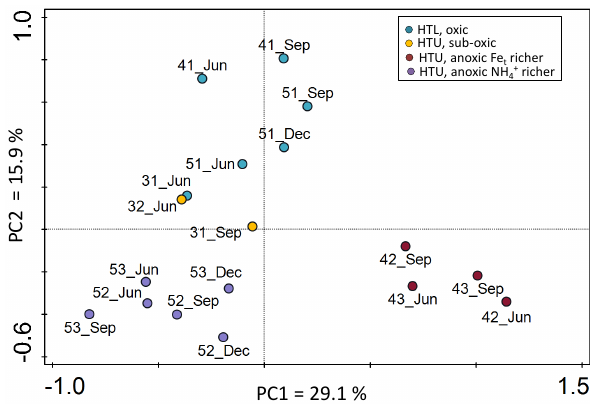
Figure 4. Principal component analysis (PCA) of PLFAs compo- sition. The different wells are represented by dots with different colours: blue for oxic groundwater, yellow for sub-oxic or oxic groundwater, dark red and violet for anoxic groundwater richer in Fe t and NH + . Note the separation between the lower and upper 4 aquifer (HTL and HTU, respectively) and the anoxic wells at loca- tions H4.2–H4.3 and H5.2–H5.3.